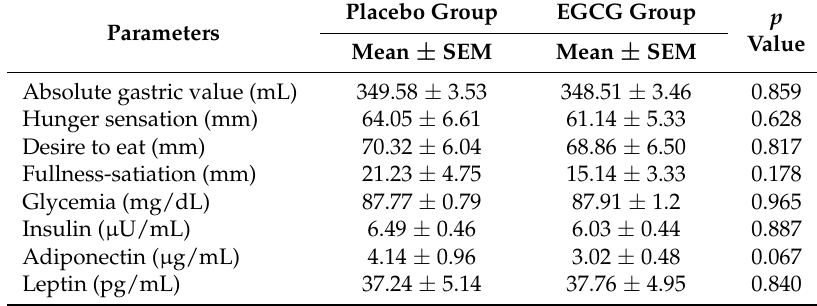
Table 2. Stomach ultrasound parameters, Visual Analogue Scale and biochemical analysis at baseline (- 5